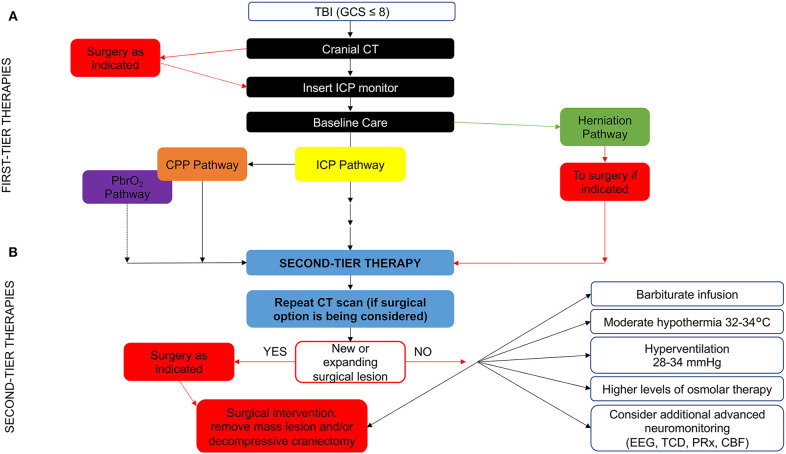
Evidence- and consensus-based algorithm of first- and second-tier therapies for pediatric TBI management. (A) The algorithm includes several components, such as baseline care (black), an ICP pathway (yellow), a herniation pathway (green), a CPP pathway (orange), and a PbrO2 pathway (purple). Solid lines identify the ICP and CPP pathways, reflecting their primary role, a dashed line identifies the PbrO2 pathway, given the fact that it represents a monitoring and management option, which is less commonly used and has less literature support. The caregiver should integrate all available information and implement the guidelines within the context of each patient's unique response to various therapies to establish the optimal treatment regimen. If baseline care is insufficient to control ICP, then progression down the ICP and CPP pathways is indicated (solid black line). First tier interventions progressing down the ICP pathway include optimized baseline care with controlled mechanical ventilation with normocarbia and adequate oxygenation, elevation of the head of the bed, nutrition, and appropriate analgesia and sedation, followed cerebrospinal fluid drainage and the use of hyperosmolar therapy as directed by ICP, CPP, or PbrO2. Please see the published TBI management algorithm (23) and Table 1 for details. The blue box indicates the need for second-tier therapy and represents the link to (B), which represents the treatment options for refractory intracranial hypertension when tier 1 approaches are insufficient. These therapies may be applied singularly, serially or in combinations. In addition, as shown, the management of refractory intracranial hypertension in the second-tier phase may be aided by the use of advanced monitoring. Data are not available on the number of patients treated with each of the first and second tier therapies given that even Guidelines-based care is highly center dependent. CBF, cerebral blood flow; CPP, cerebral perfusion pressure; CT, computed tomography; EEG, electroencephalogram; GCS, Glasgow Coma Scale; ICP, intracranial pressure; PbrO2, brain tissue partial pressure of oxygen; PRx, pressure reactivity index; TBI, Traumatic brain injury; TCD, transcranial Doppler ultrasonography. Graphical elaboration of text and Figures 1, 2 in (23).